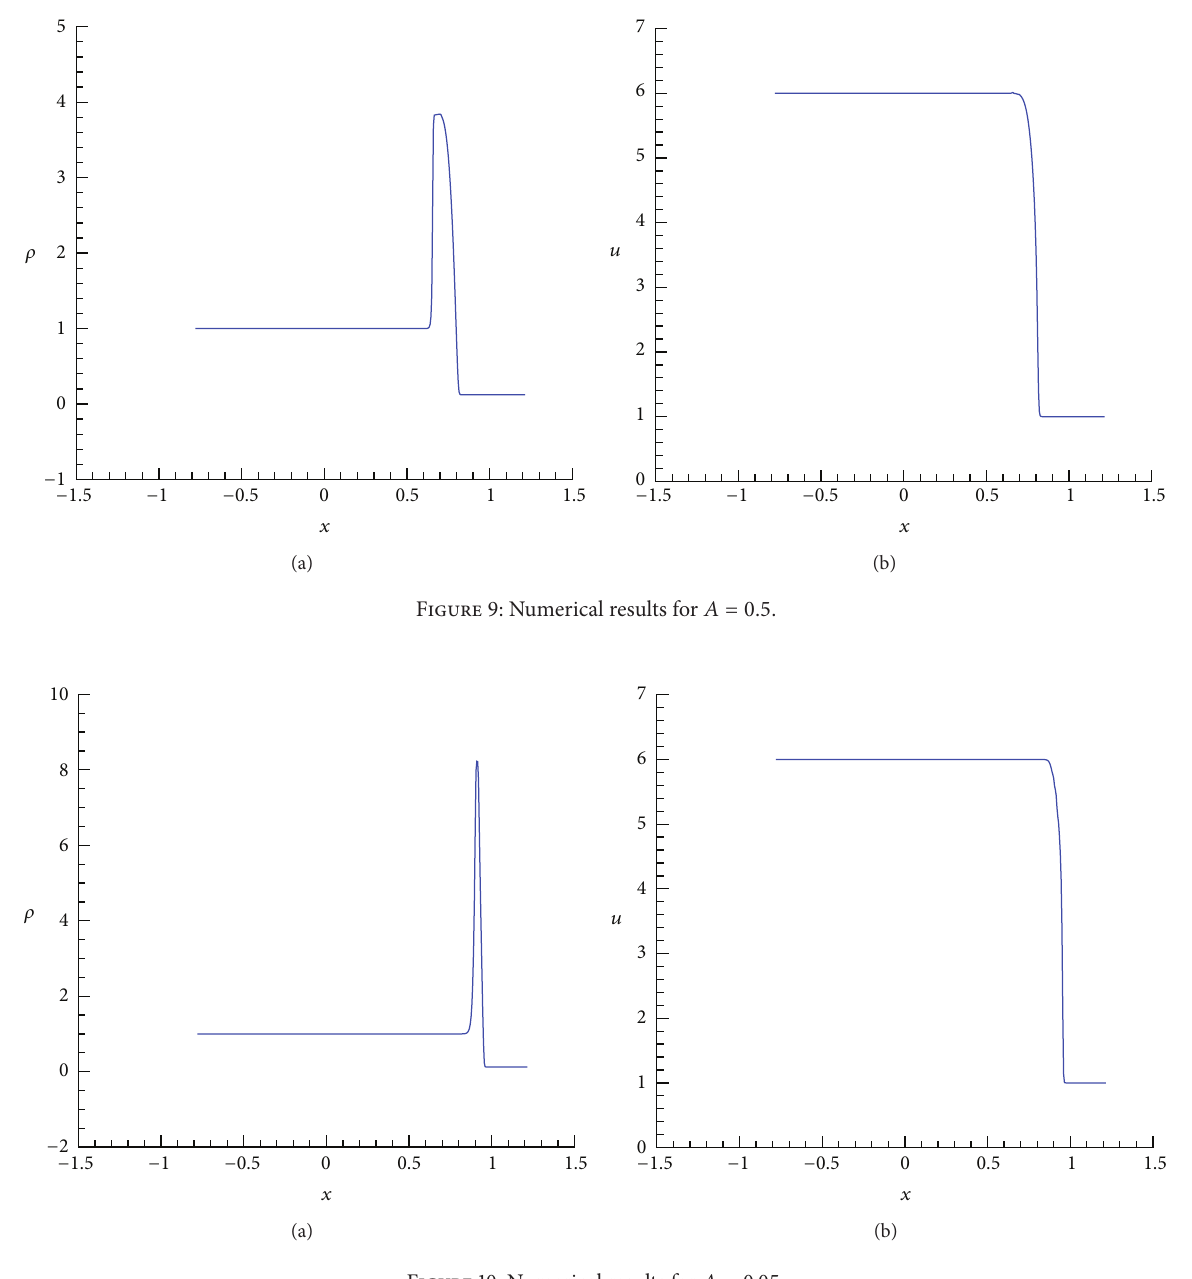
Figure 10: Numerical results for 𝐴 = 0.05